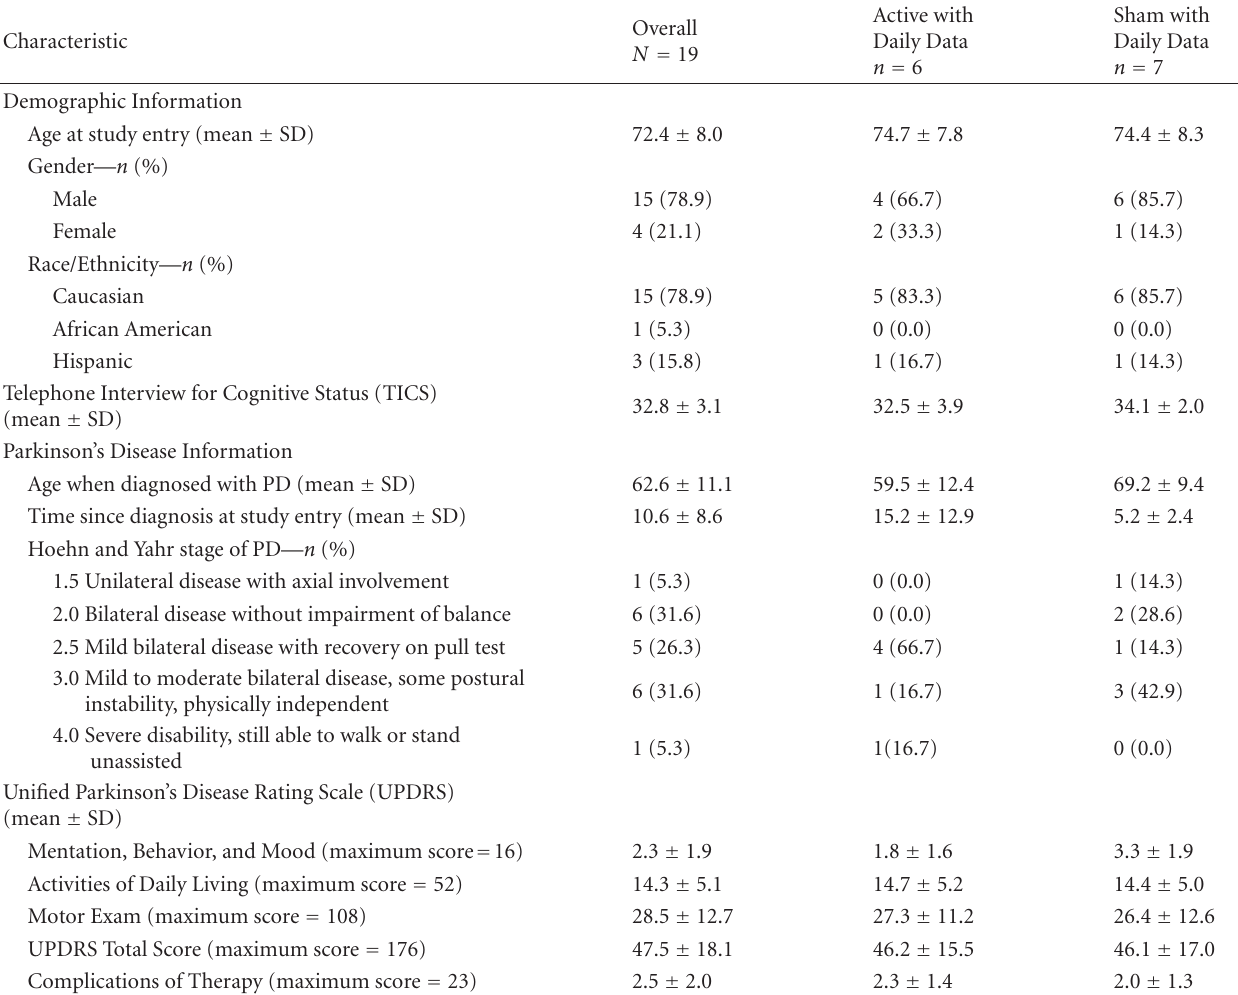
Table 2: Characteristics of the